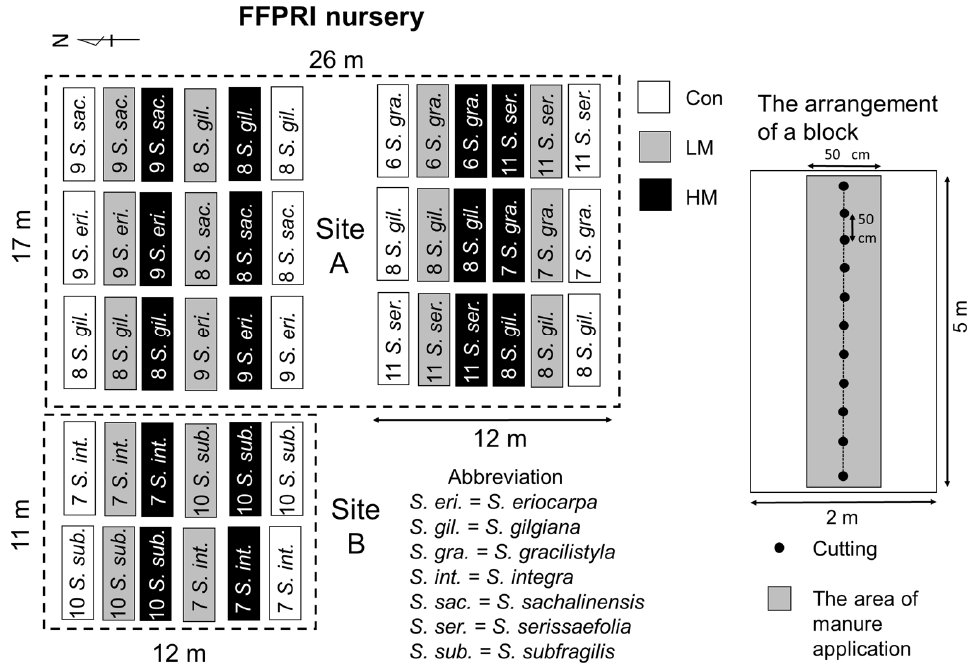
Figure 3. Schematic design of FFPRI nursery ( left ) and the arrangement of a block ( right ). We planted cuttings of S. eriocarpa , S. gilgiana , S. gracilistyla , S. sachalinensis , and S. serissaefolia in 2019 at Site A. We planted cuttings of S. integra and S. subfragilis in 2020 at Site B. Squares of white, grey, and black show Con, LM, and HM treatments, respectively. Numbers written beside the names of abbreviated willow species show the numbers of planting cuttings. The interval of planting of cutting was 50 cm, and width of compost application was 50 cm width around the planting line. The interval of planting line between the two blocks was 2 m.